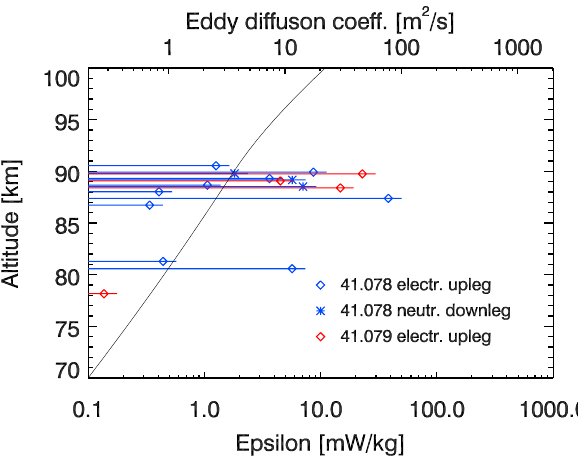
Fig. 7. Turbulent energy dissipation rates derived from the observa- tion of the inner scale in the fluctuation spectra. The thin line indi- cates (cid:15) min ∼ νN 2 , a threshold for significant levels of